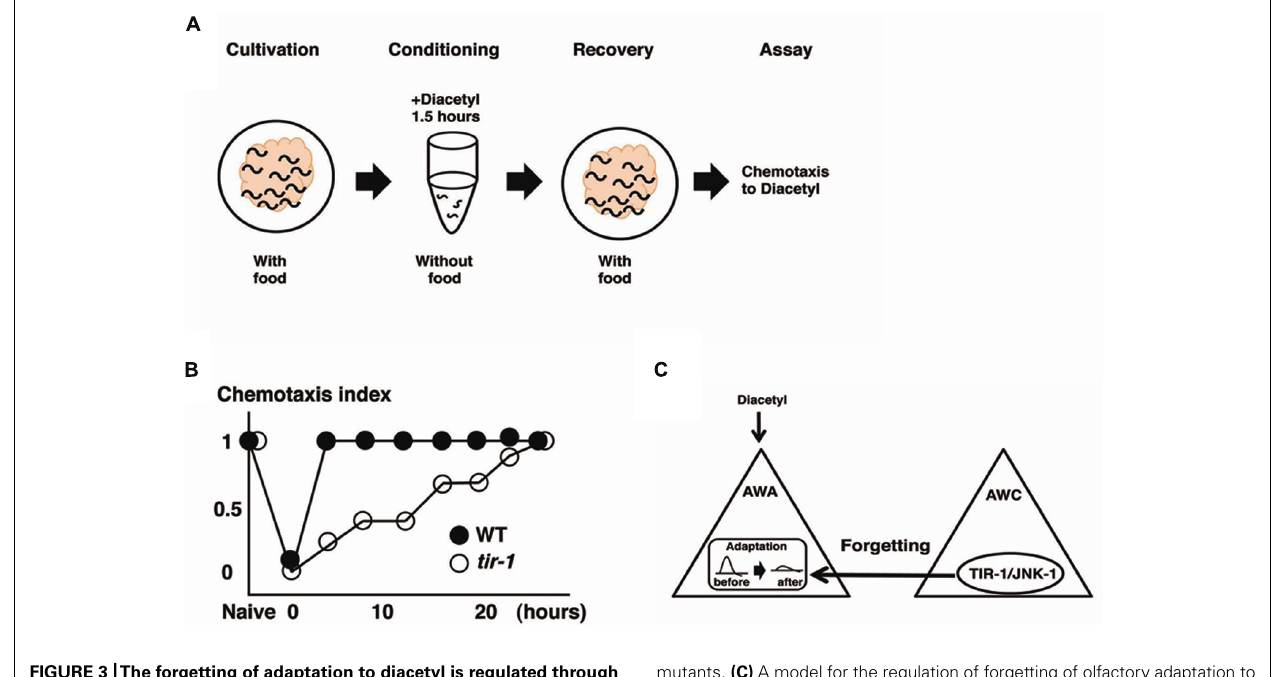
mutants. (C) A model for the regulation of forgetting of olfactory adaptation to diacetyl.TheTIR-1/JNK-1 pathway in AWC neurons regulates the forgetting process of adaptation in AWA